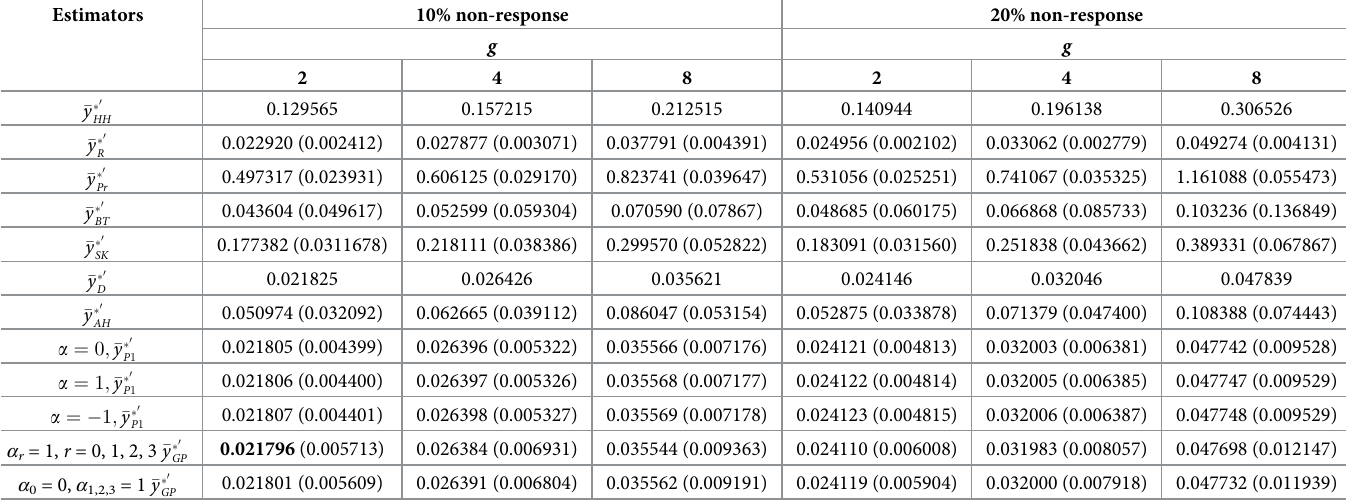
Table 4. Mean squared error and | Bias | (in brackets) values for different estimators for Population II with measurement error.